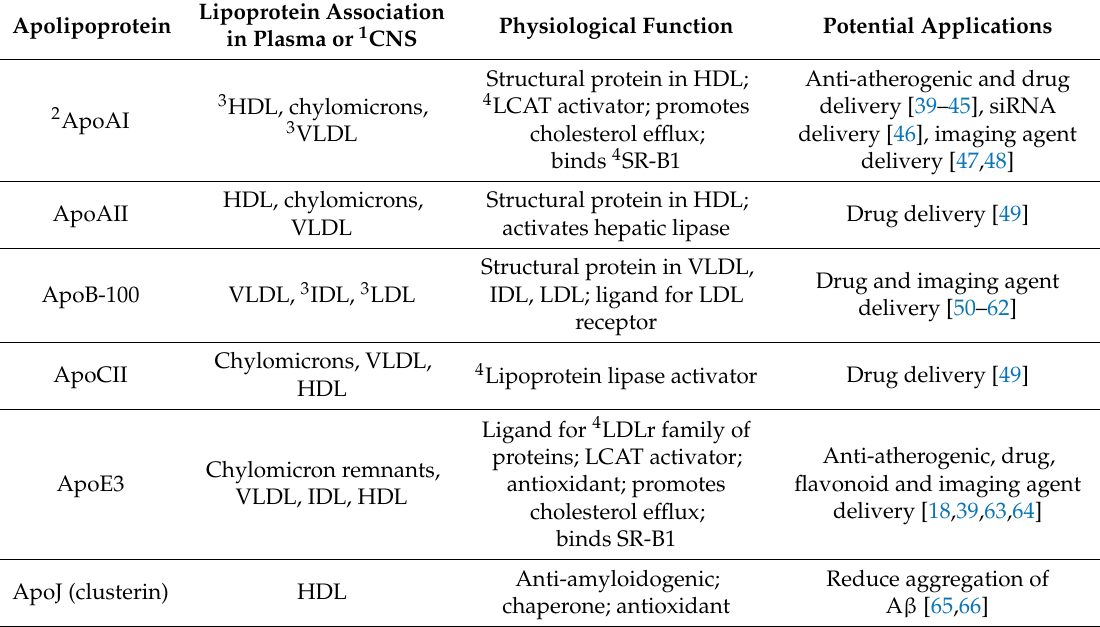
Table 1. Apolipoproteins used in nanoparticles and their potential applications.